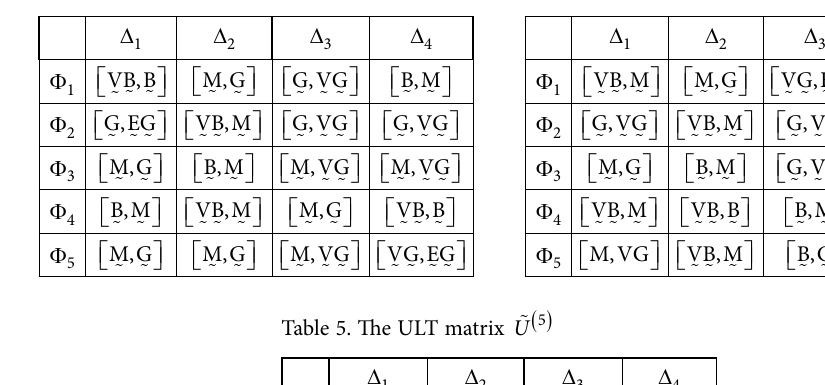
Table 3. The ULT matrix Table 4. The ULT matrix